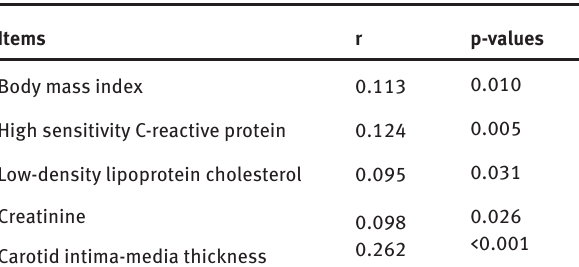
Table 2: The correlation between serum CA125 and laboratory parameters in all patients